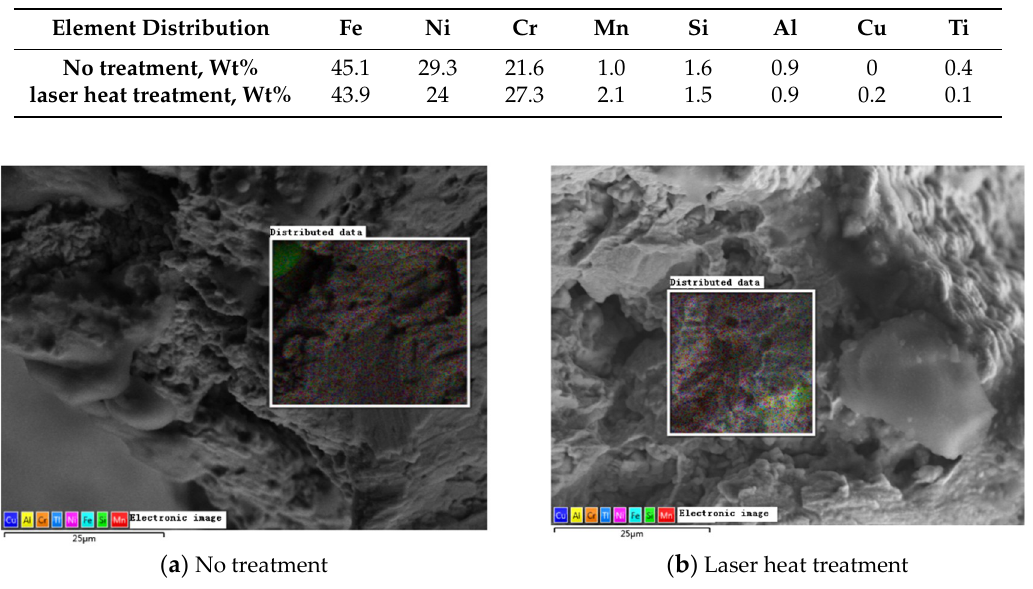
Table 2. Element composition results of sample by energy spectrum analysis.